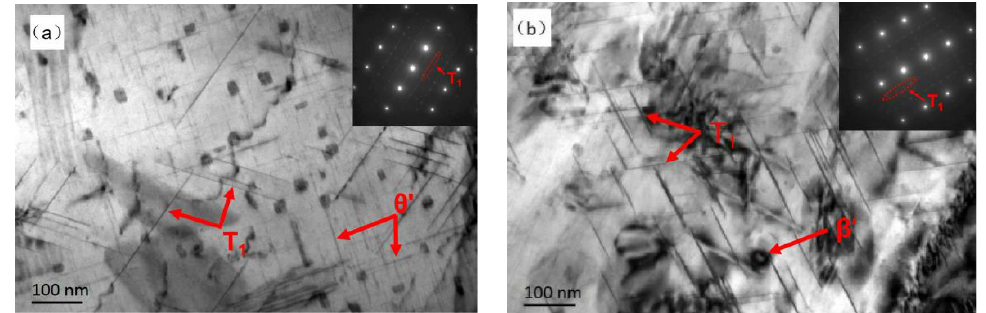
Figure 10. TEM bright field micrographs and diffraction patterns of 2A90 alloy after T6 treatment taken along 112 Al direction ( a ) Conventional DC casting; ( b ) LFEC with 10 Hz / 150 A.